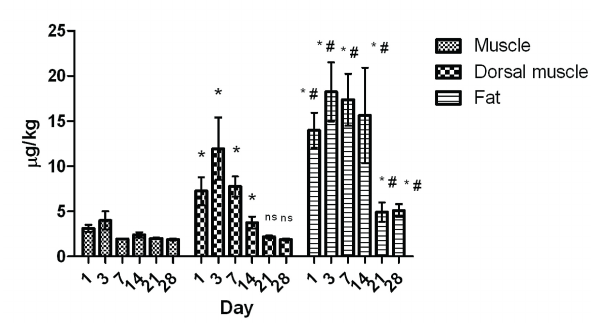
in muscles 1a residues in milk (μg kg -1 Bw) from cows Figure 7: Eprinomectin B 1a treated with pour-on product dose of 1 mL per 10 kg of body weight (500 μg eprinomectin kg -1